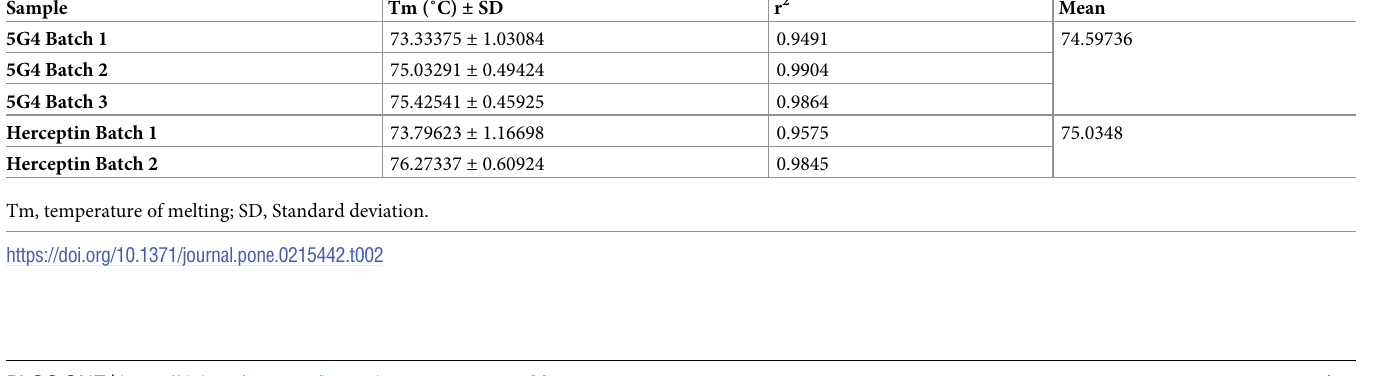
Table 2. The temperature of melting for 5G4 mAb and Herceptin.